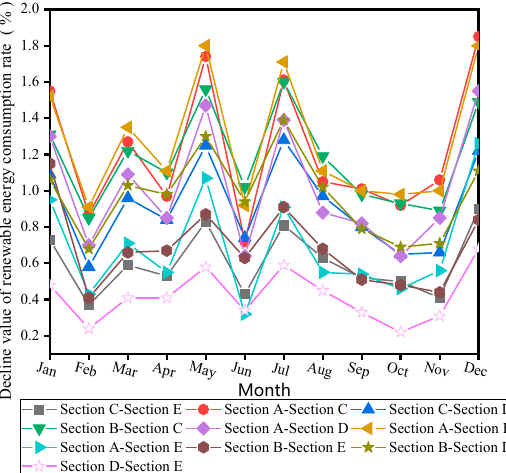
Figure 5. Decrease in the value of the renewable energy consumption rate with the simultaneous maintenance of two transmission sections.